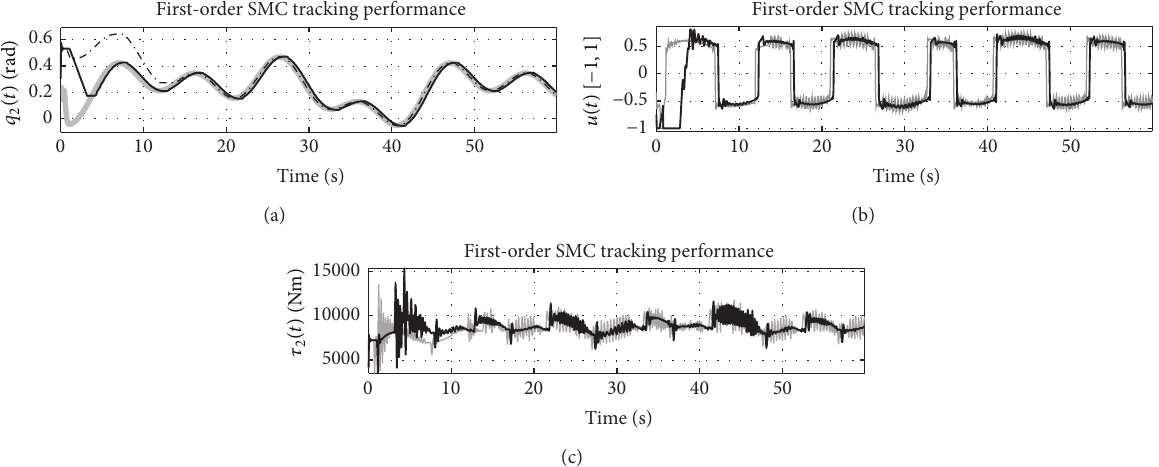
Figure 11: Experimental results of tracking performance with a first-order SMC. (a) Angular link displacement in radians . The bold signal shows the results applying the chattering reduction method (47), the striped signal shows results with the original formula (36), and the gray signal is the reference trajectory. (b) Control input . The bold signal shows the results applying the chattering reduction method (47) and the gray signal shows results with the original formula (36). (c) Computed torque from pressure measurements . The bold signal shows the results applying the chattering reduction method (47) and the gray signal shows results with the original formula (36).